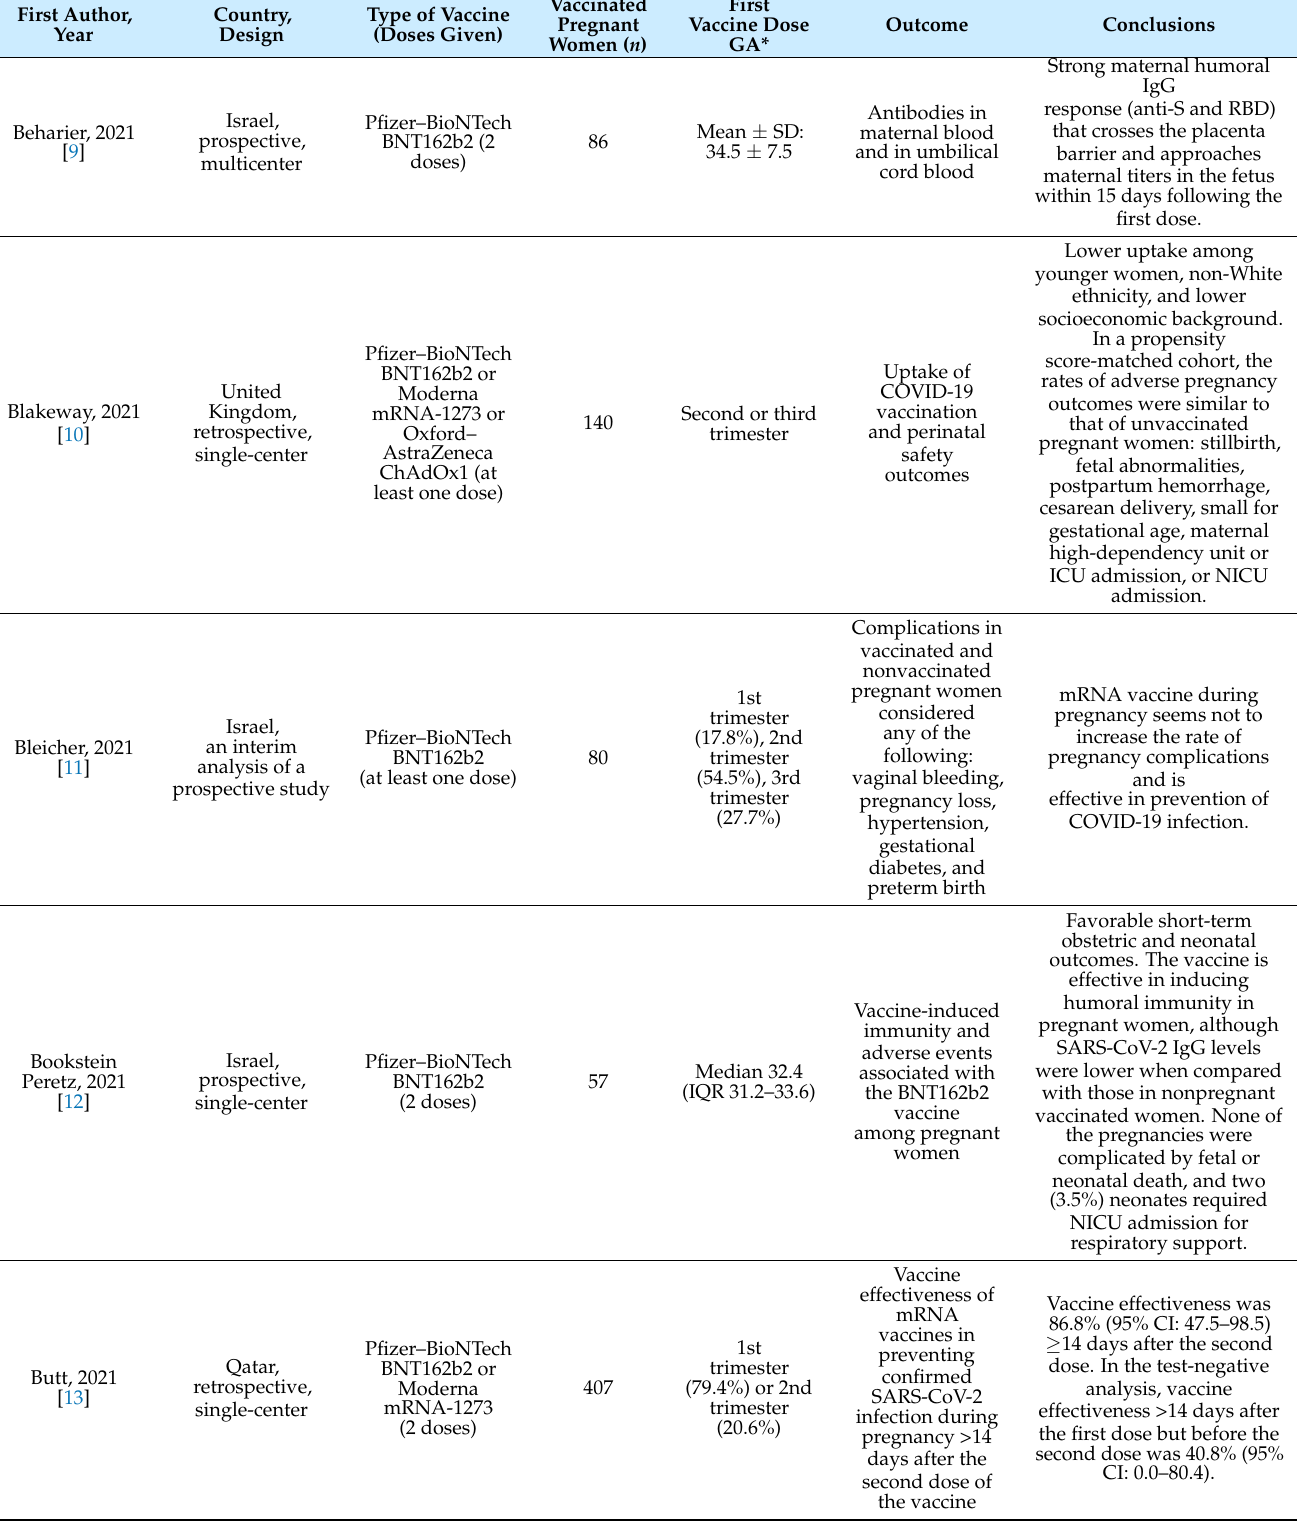
Table 1. List of the 32 studies including pregnant mothers who received SARS-CoV-2